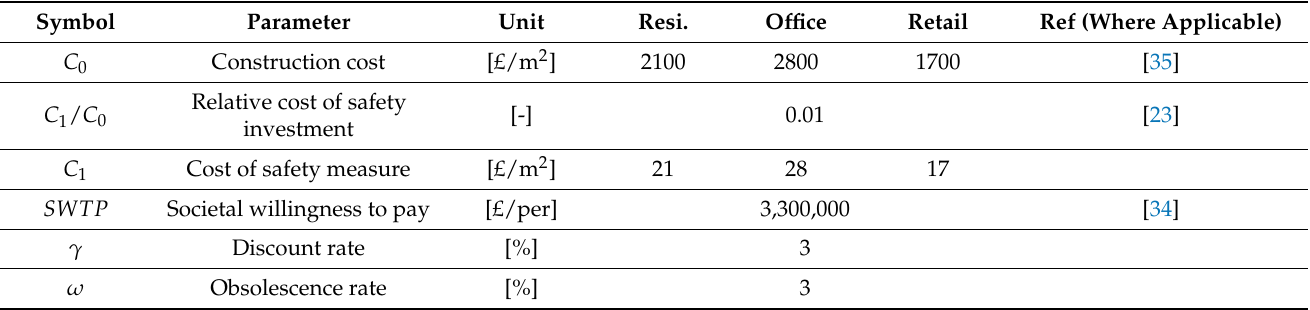
Figure 6. Conditional acceptable failure probability in the event of a structurally significant fire in function of the number of fatalities based on the principle of relative (marginal) lifesaving costs ( left ) without sprinklers, ( right ) with sprinklers.